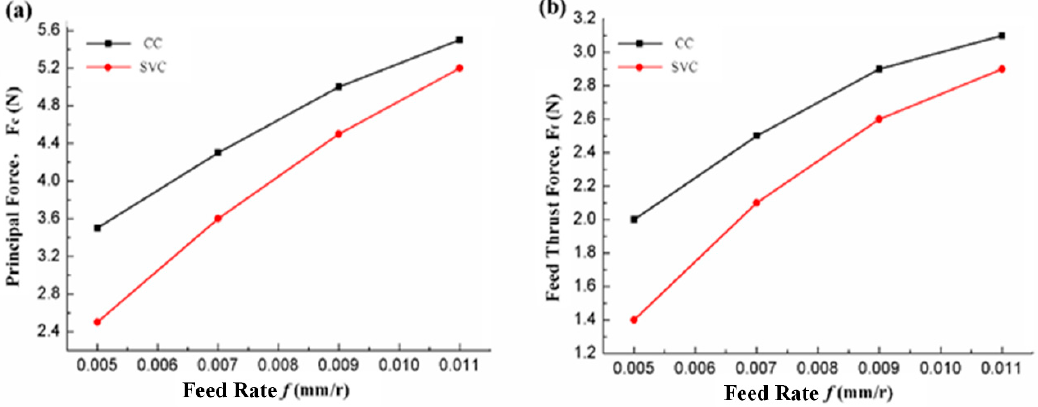
Figure 8. Average ( a ) principal and ( b ) feed thrust forces vs. feed rate (depth of cut, 0.025 mm; cutting speed, 200 m/min).